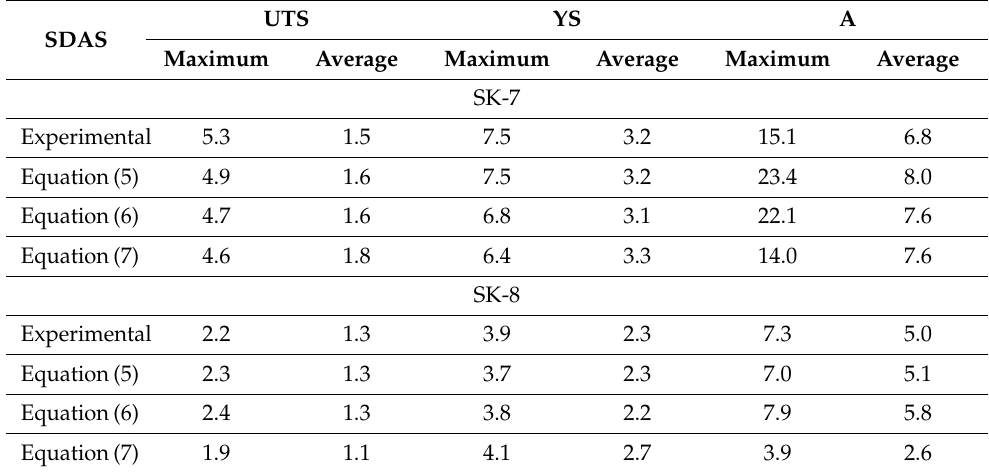
Figure 24. Comparison of experimental A values obtained from the SK-8 castings and those pre- dicted by using Equation (29) and data included in Table 11. Two different SDAS parameters are used: experimentally measured SDAS ( a ) and the values of this parameter determined with Equation (6) ( b ). Black symbols correspond to SK-8 castings manufactured with 0.30 wt.% Mg (open circles) and with 0.31 wt.% Mg (solid circles) while red symbols correspond to castings produced with 0.33 wt.% Mg (open circles) and with 0.34 wt.% Mg (solid circles). All SK-8 castings were aged at 155 ◦ C for 360 min. Solid lines are the bisectors. Table 13. Maximum and average RD values (%) obtained when comparing experimental UTS, YS and A data with the corresponding predicted